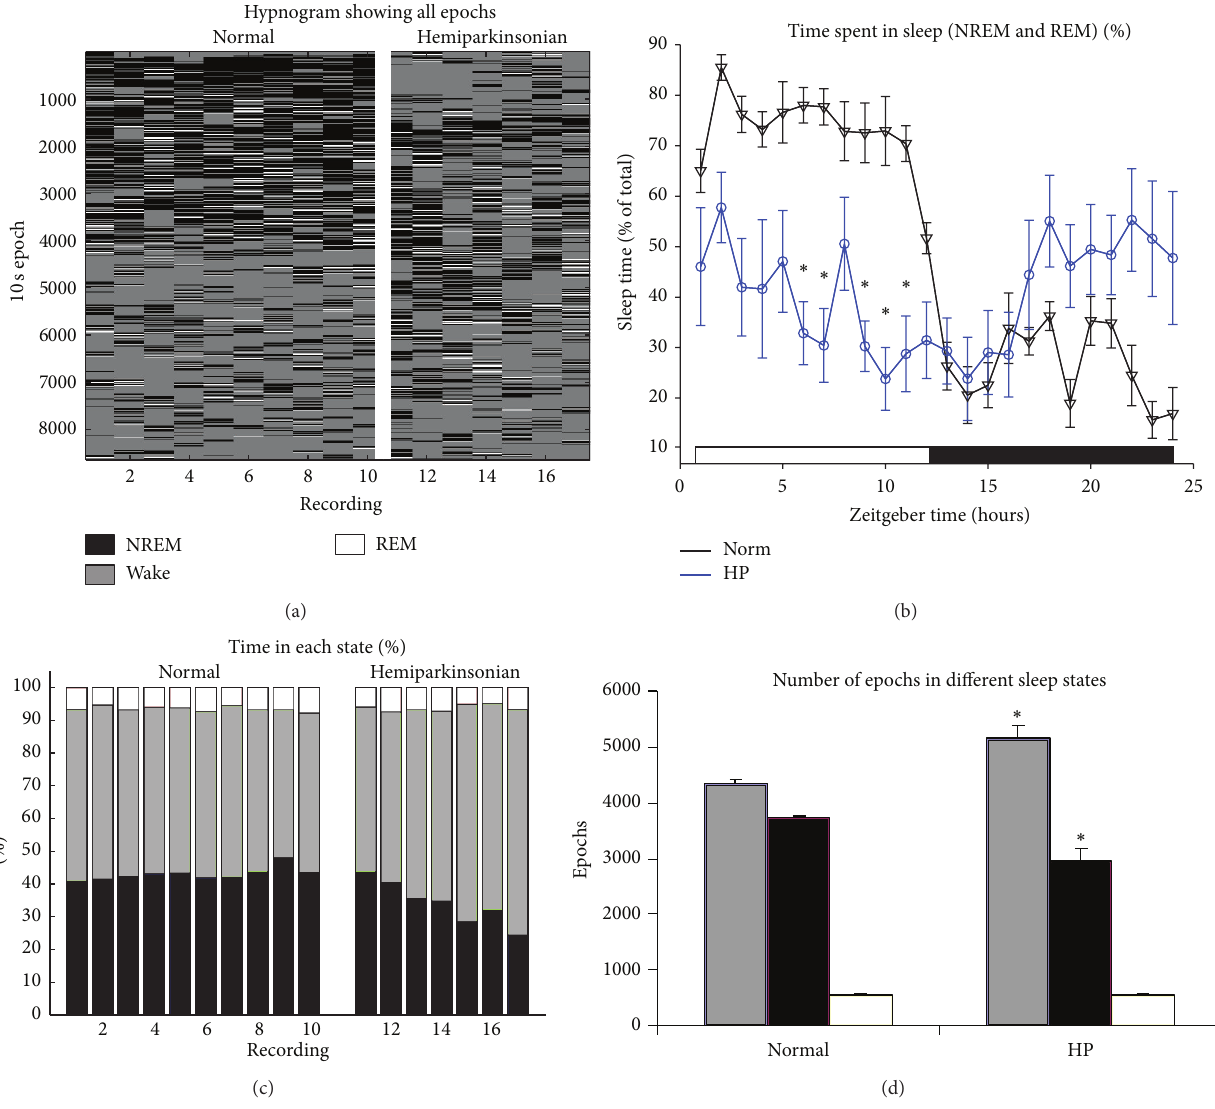
Figure 3: Overview of sleep structure in 24-hour recordings. (a) Plot of all sleep and wake 10-second epochs throughout the 24-hour recordings (numbered columns). Columns 1–10 show recordings from 10 normal rats (1 recording from each rat). Columns 11–17 show recordings from 5 HP rats (columns 11-12 and columns 13-14 show consecutive 24-hour periods from two HP rats, resp.). The top of the 𝑦 -axis shows the beginning of the day when the lights were turned on. (b) Plot of hourly average sleep (combined NREM and REM) percentages across the entire 24 hours (error bars show SEM). (c) Percentages of epochs in NREM, wake, or REM states (colors and column labels are identical to (a)). (d) Number of epochs in different sleep states ( ∗ 𝑃 < 0.05 , two-sided 𝑡 -test between normal and HP rats; colors are identical to